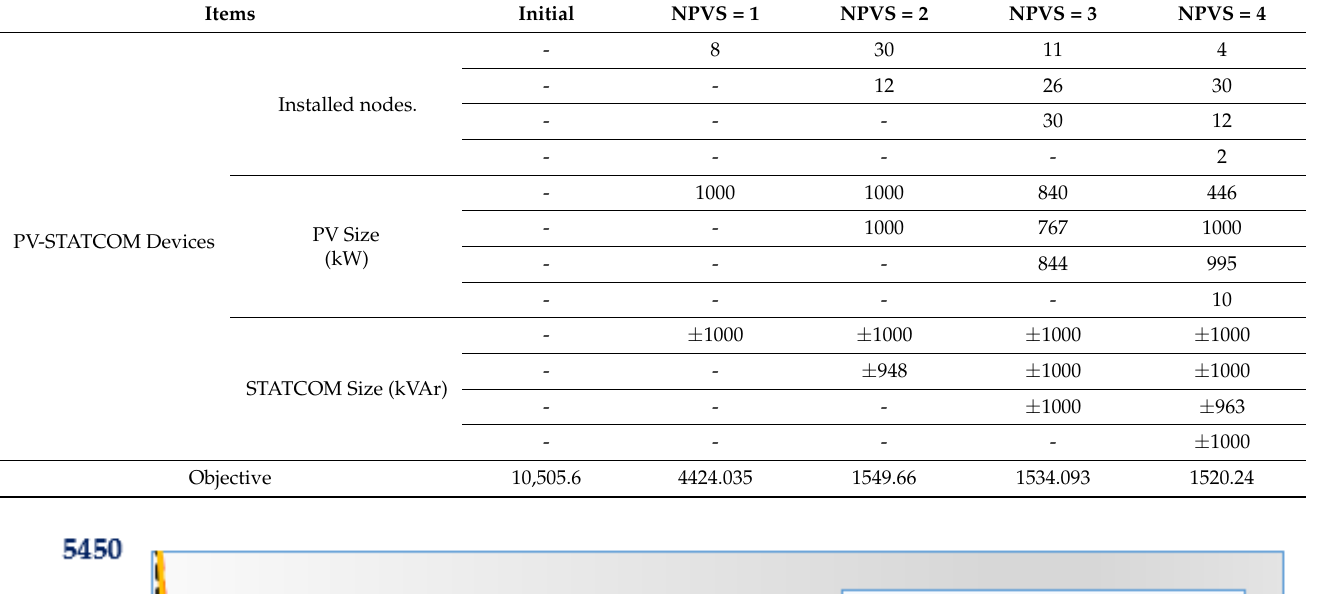
Table 2. PV-STATCOM allocations with varying the number of installed devices for IEEE 33-distribution feeder.